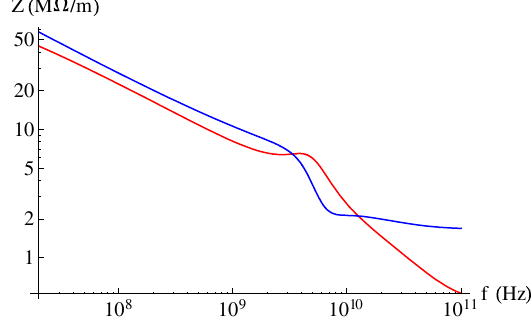
FIG. 4. Horizontal impedance, nominal [20].